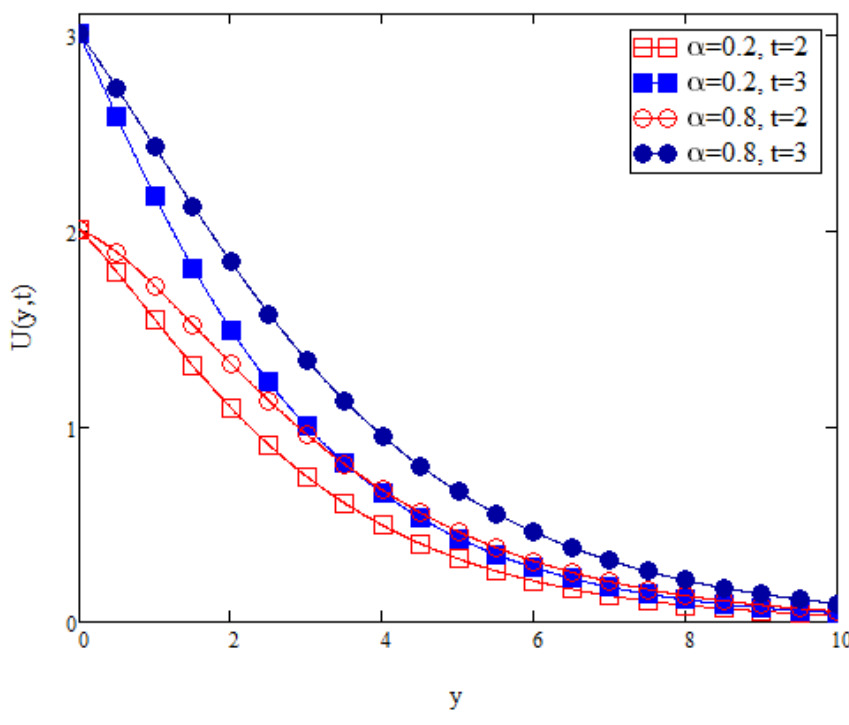
Figure 19. Variation in velocity profile due to variations in t and α